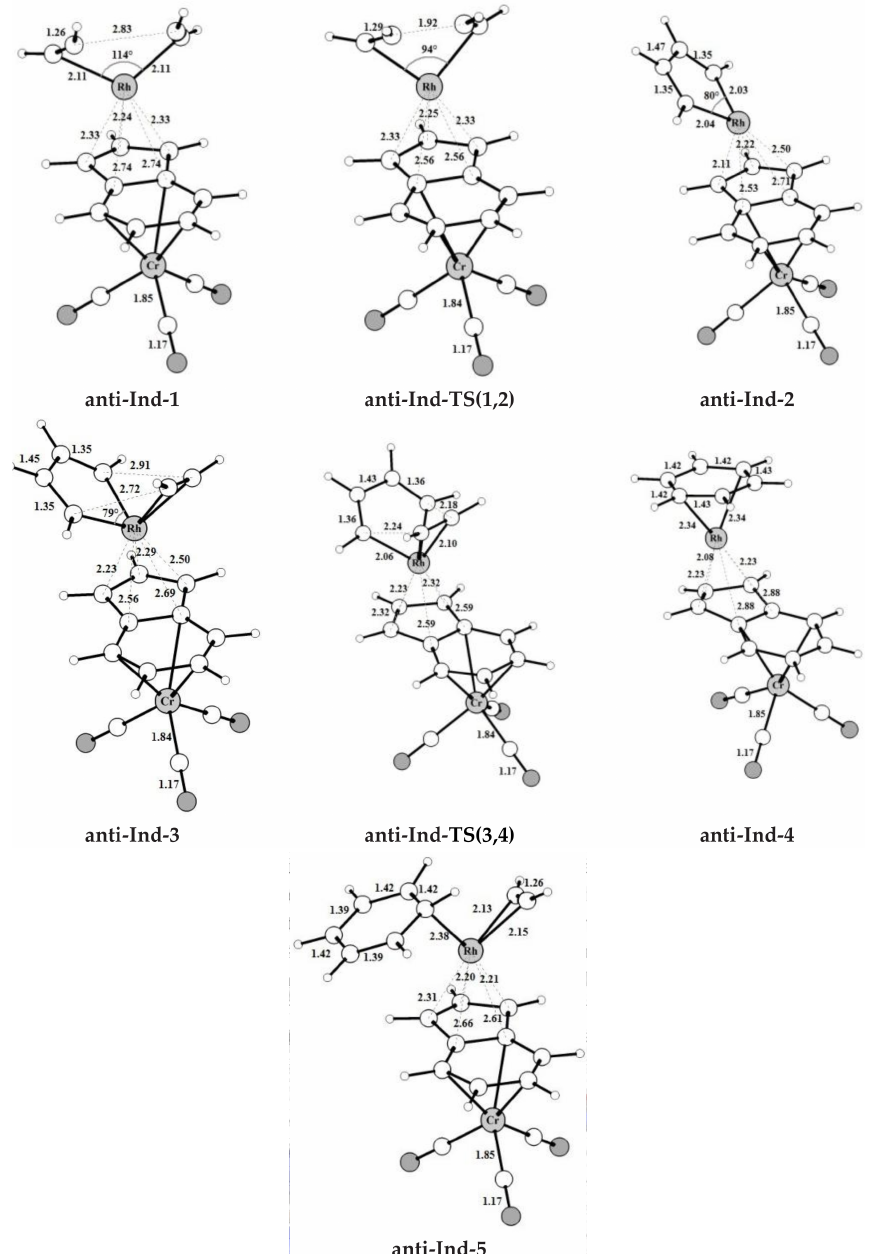
Figure 1. Optimized structures with selected interatomic distances (Å) and angles (deg) of the intermediates and transition states located on the PES of the anti-IndRh catalyzed acetylene [2 + 2 + 2] cycloaddition to benzene (Path I, Scheme 2a). Level of theory: ZORA-BLYP /